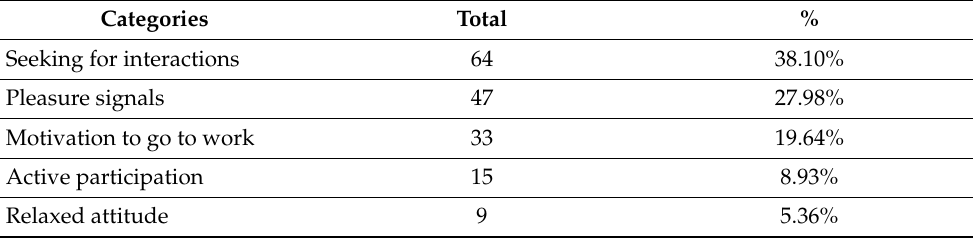
Table 10. This table represents handlers’ answers on how their dog communicates his pleasure during sessions; n = 168 terms